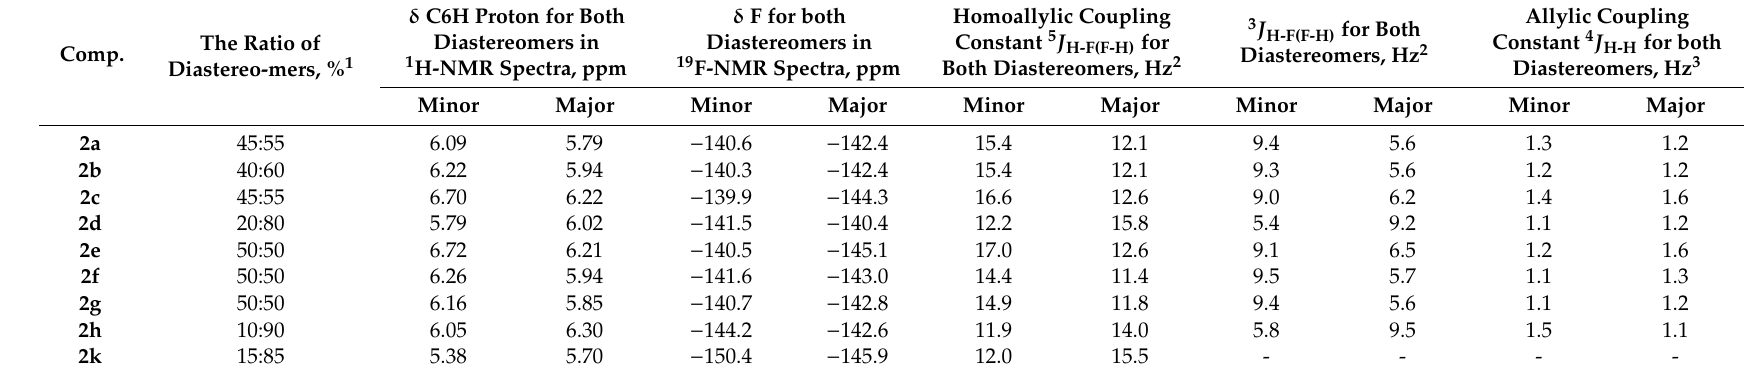
Table 3. The general NMR spectral characteristics of 3-fluoro-3,6-dihydropyridines 2a – k .